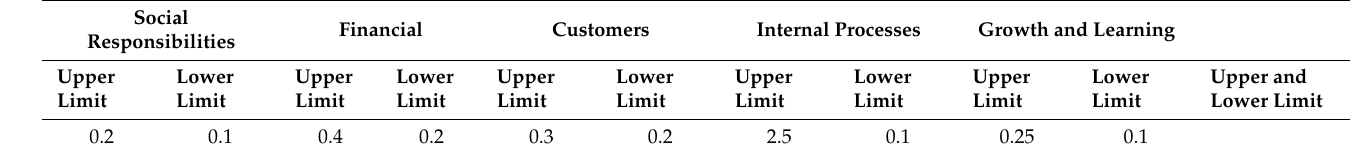
Table 5. Upper and lower limits of balanced scorecard